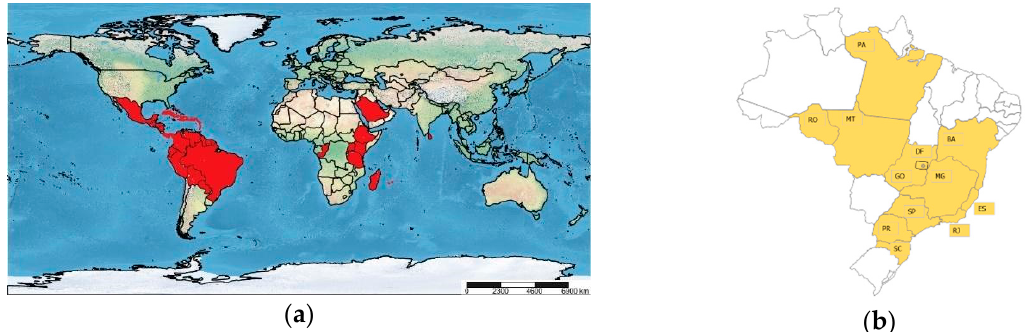
Figure 1. Presence of L. coffeella in: ( a ) The world map, showing producing countries highlighted in red: North and Central America: Antigua and Barbuda, Barbados, Costa Rica, Cuba, Dominica, Dominican Republic, El Salvador, Grenada, Guadeloupe, Guatemala, Haiti, Honduras, Jamaica, Martinique, Mexico, Montserrat, Nicaragua, Puerto Rico, Saint Lucia, Saint Vincent and Grenadines, Trinidad and Tobago; South America: Bolivia, Brazil, Colombia, Ecuador, French Guiana, Guyana, Peru, Suriname and Venezuela; Africa: Reunion, Mauritius, Madagascar, Uganda, Kenya, Congo, Ethiopia, Tanzania and Rwanda; Asia: Saudi Arabia and Sri Lanka, and ( b ) Brazil, highlighting in yellow the affected producing states: RO = Rondônia, MT = Mato Grosso, PA = Pará, GO = Goiás, DF = Distrito Federal, BA = Bahia, MG = Minas Gerais, ES = Espírito Santo, SP = São Paulo, RJ = Rio de Janeiro, PR = Paraná, SC = Santa Catarina.